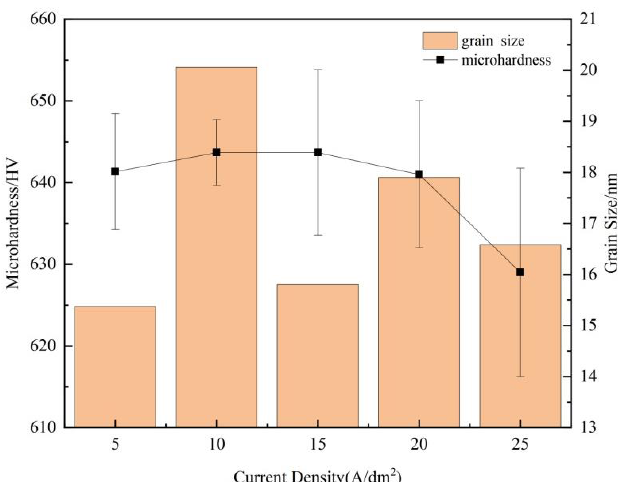
Figure 8. Grain size and microhardness of ternary alloy coatings at different current densities.